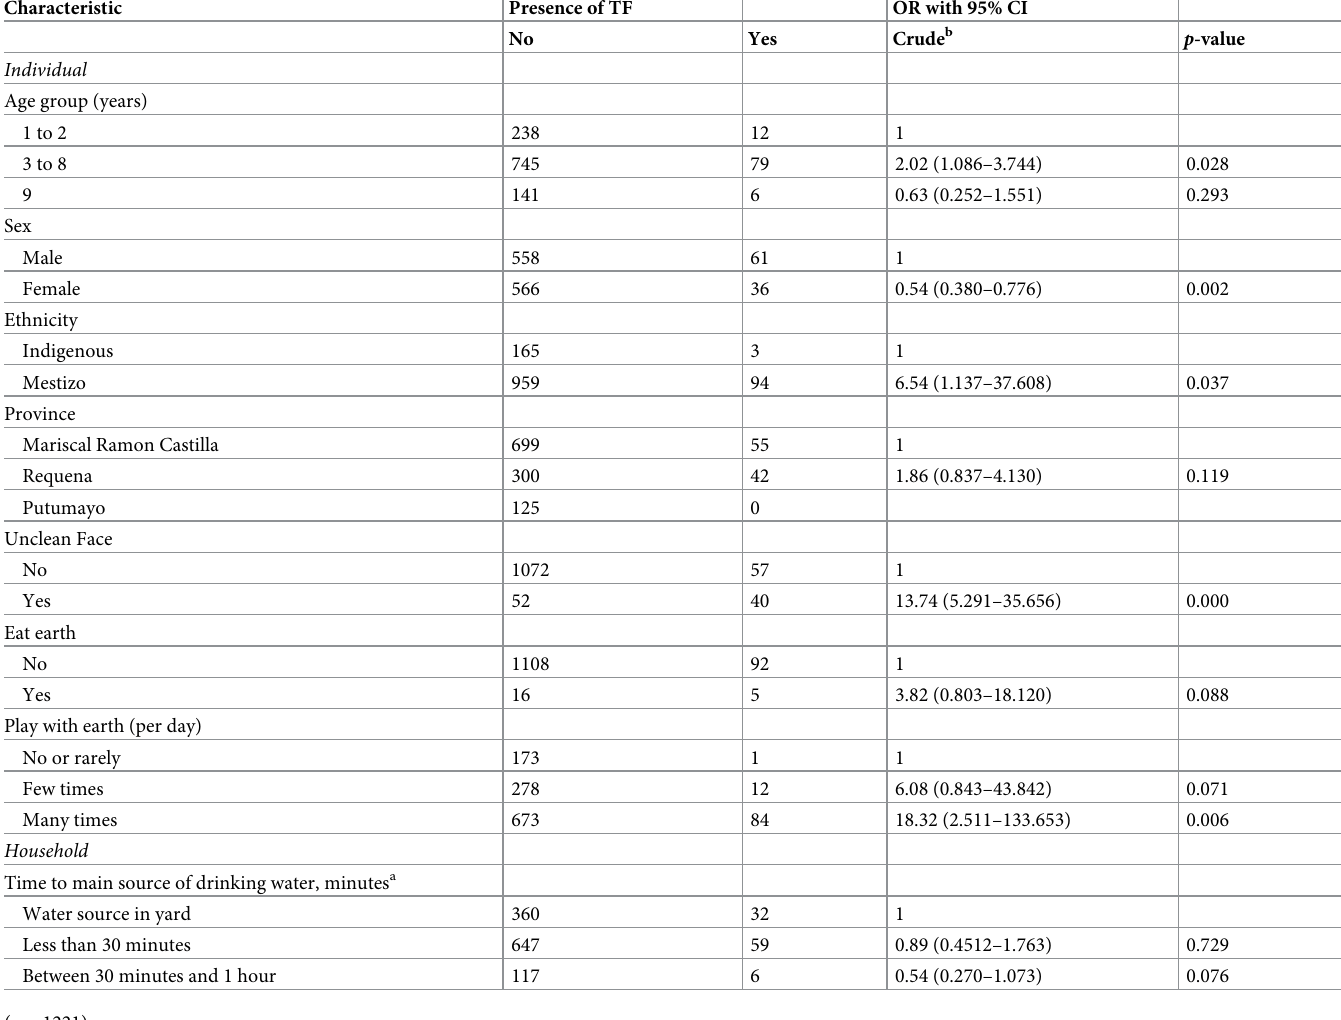
Table 8. Bivariate logistic regression analysis of factors associated with trachomatous inflammation-follicular (TF), among children aged 1–9 years, rural commu- nities of Loreto Department, Peru 2017.